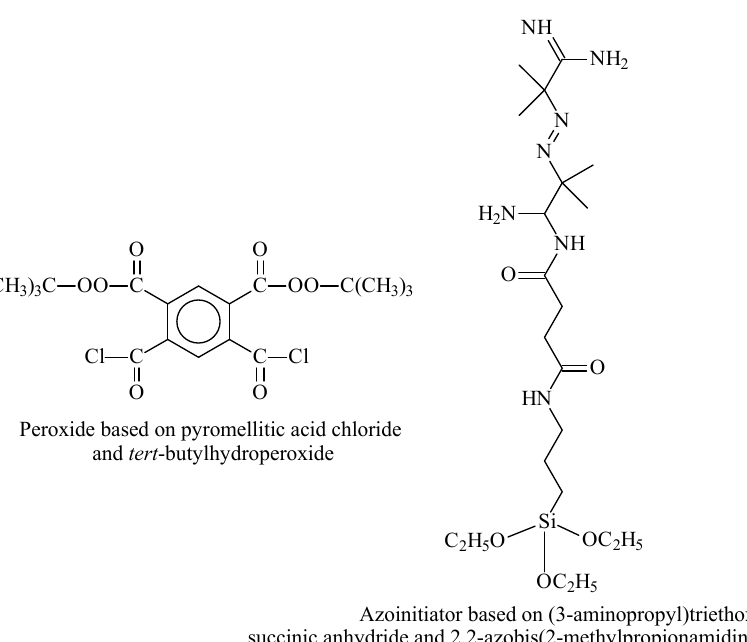
Table 1. The examples of multifunctional initiators for surface-initiated polymerizations. Type of Polymerization Based on the Chemistry of Initiators